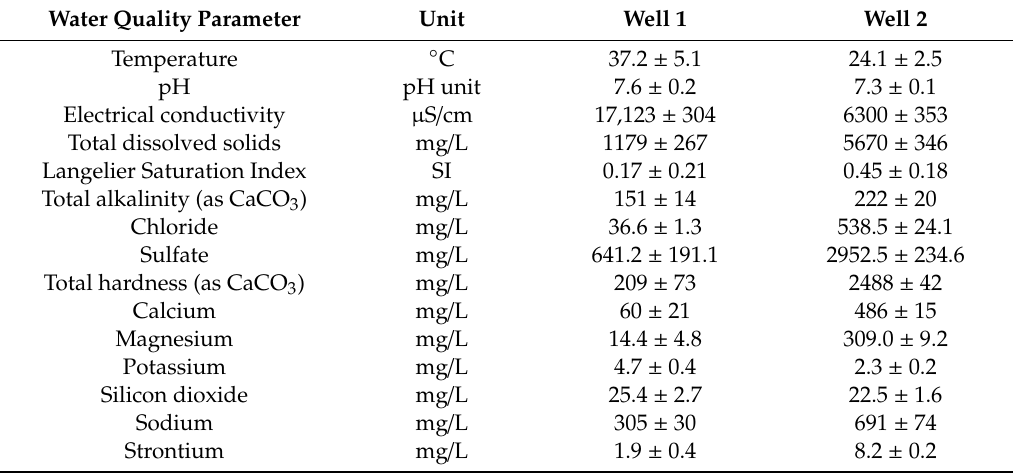
Table 1. Groundwater quality for RO testing at